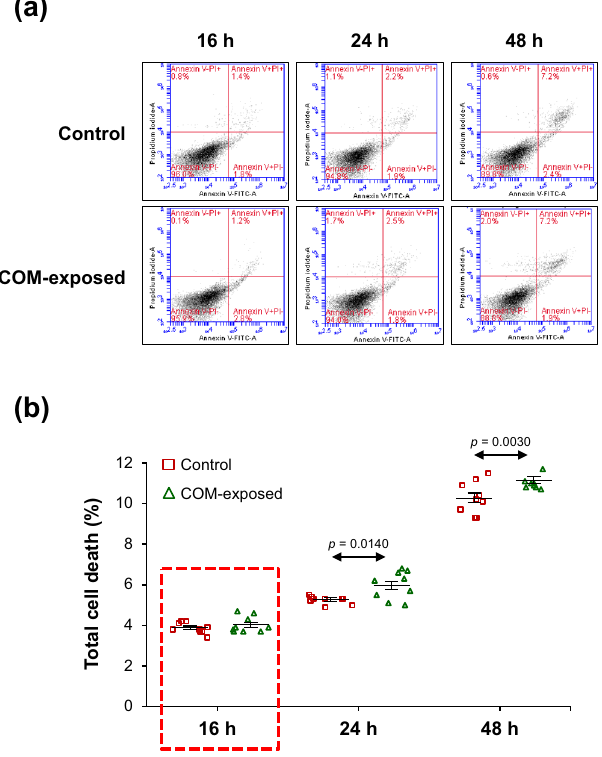
Fig. 1 Cell death assay by fl ow cytometry with annexin V/propidium iodide co-staining. Macrophages were incubated in serum-free medium with or without 100 µ g/ml COM crystals for 16, 24, and 48 h. The cells were then collected and co-stained with annexin V and propidium iodide followed by fl ow cytometric analysis. a Scatter plots showing fl uorescence signal of FITC-conjugated annexin V (X-axis) and propidium iodide (Y- axis). b Quantitative analysis of cell death calculated by using Formula 1. The data were obtained from three independent experiments using different biological replicates and the bars indicate mean ± SEM (all the source data are presented in Supplementary Data 1). Red-dashed rectangle indicates the optimal time-point that was chosen for all subsequent